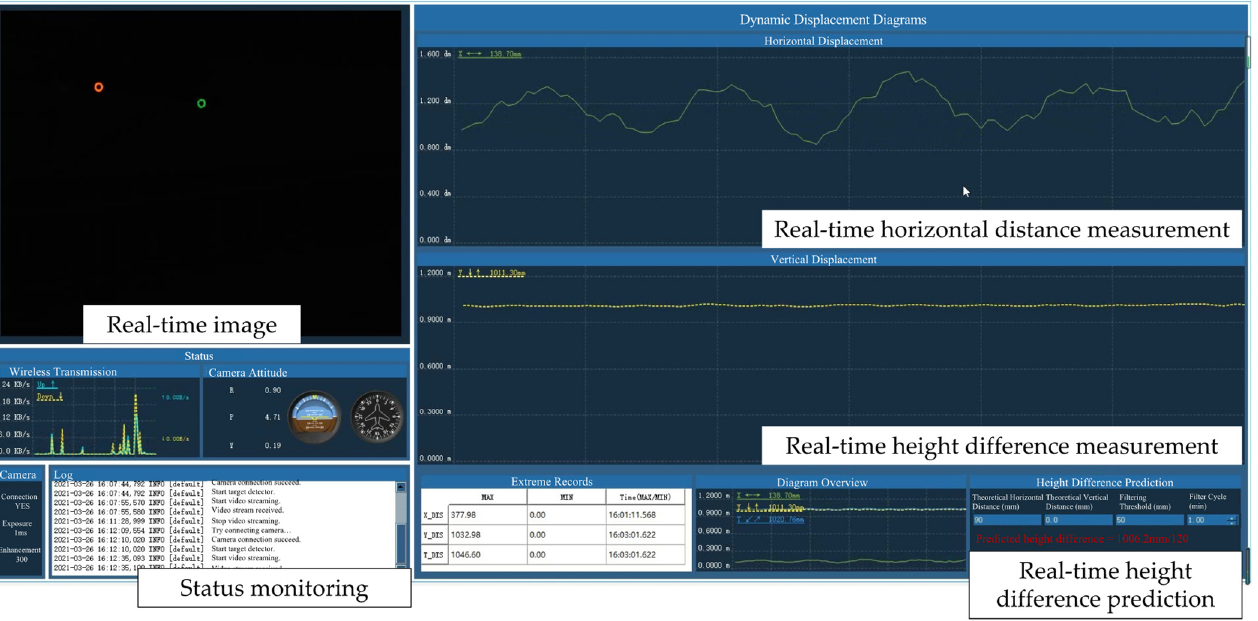
Figure 16. Screenshots of the visual monitoring software. In order to eliminate the influence of wind-induced transverse swing and vertical vibration of the strands, Equation (8) is used to predict the static height difference ( H cal